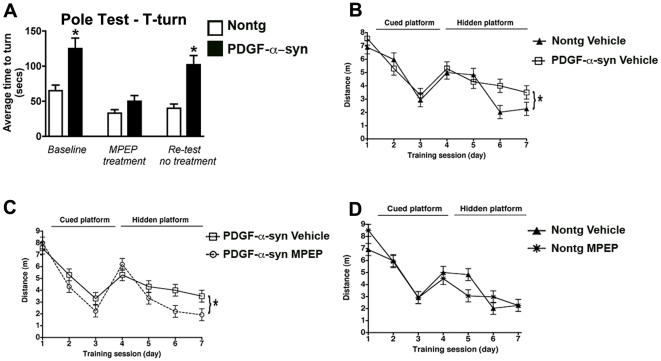
Motor and learning/memory deficits in alpha-syn transgenic mice are ameliorated by MPEP administration.(A) Pole test performance (T-Turn) of the non-tg and PDGF-alpha-syn tg mice, at baseline, following MPEP treatment and at re-test (no treatment). (B) Morris water maze performance of vehicle-treated non-tg and PDGF-alpha-syn tg mice. (C) Morris water maze performance of MPEP- treated PDGF-alpha-syn tg mice. (D) Morris water maze performance of MPEP-treated non-tg mice. * Indicates a significant difference between groups examined (p<0.05, one-way ANOVA and post hoc Fisher) (n = 8 per group).